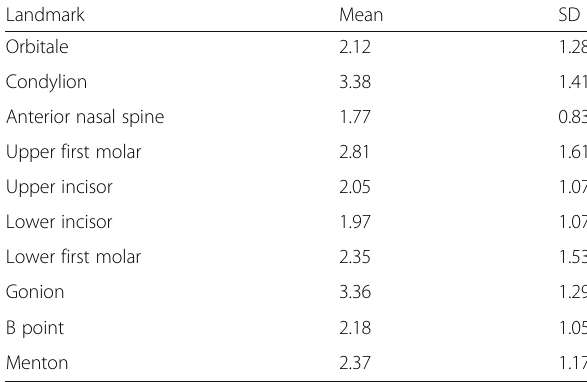
Table 2 Reference facial asymmetry index in the normal